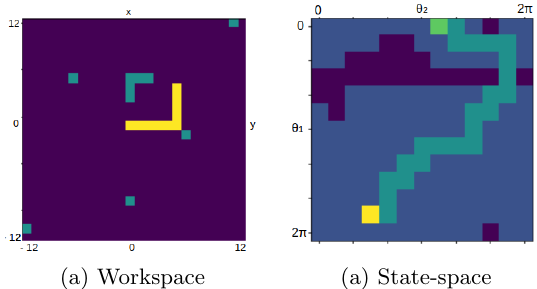
Figure 4: Solutions to the 2-link manipulator as shown in Figure 2. (a) the manipulator (yellow) in its workspace. Obstacles are turquoise. (b) the systems state-space where the y-axis is θ 1 and the x-axis θ 2 . Dark blue states repre- sent collision with an obstacle and light blue states are allowable states. The turquoise path shows the solution when moving from the green state to the yellow